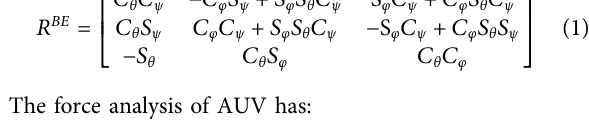
FIGURE 1 | Relationship between ground coordinates and airframe